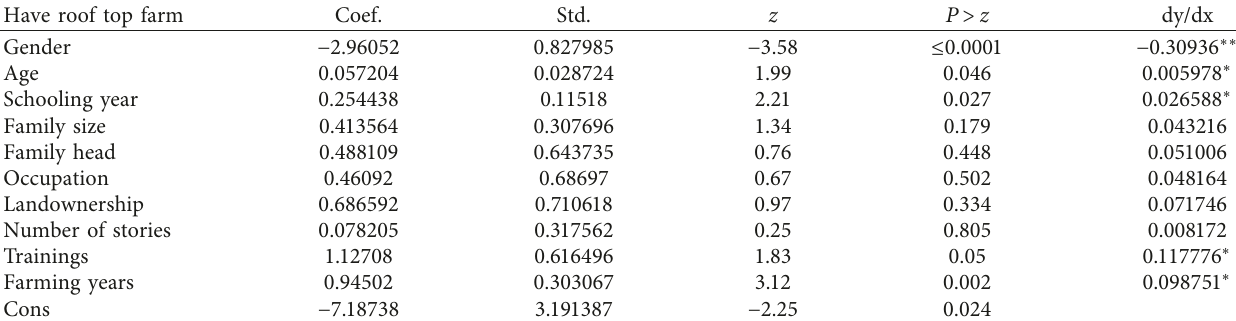
Table 7: Factors affecting in adoption of rooftop garden: an analysis using binary logit model. Have roof top farm